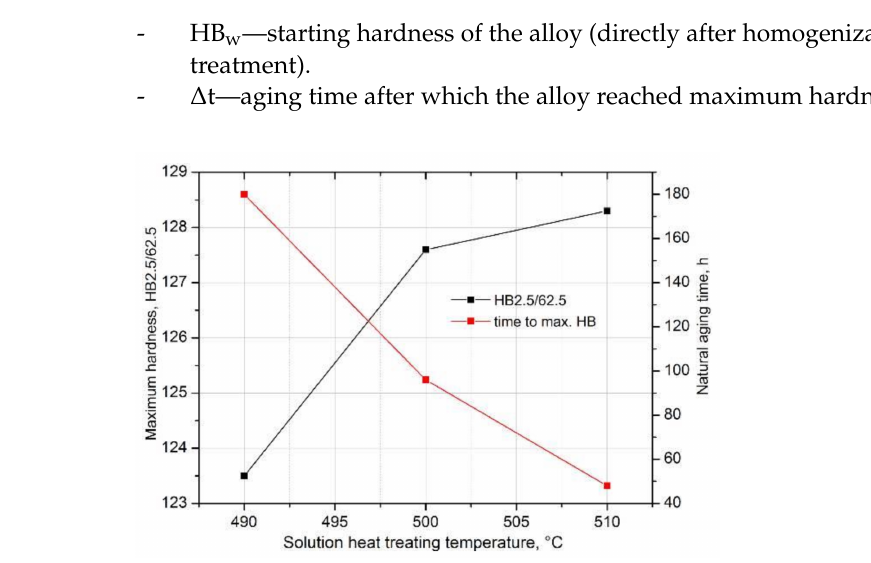
Figure 13. Influence of solution heat treatment temperature on the value and time to obtain the maximum hardness for the 2017A aluminium alloy naturally aged at ~25 ◦ C. The values of parameters determined from aging curves HBW2.5/62.5 = f(t); T = const and hardness gradient calculated from Equation (1) are presented in Table 4. Table 4. Parameter values determined from aging curves necessary to determine hardness gradient grad HB.